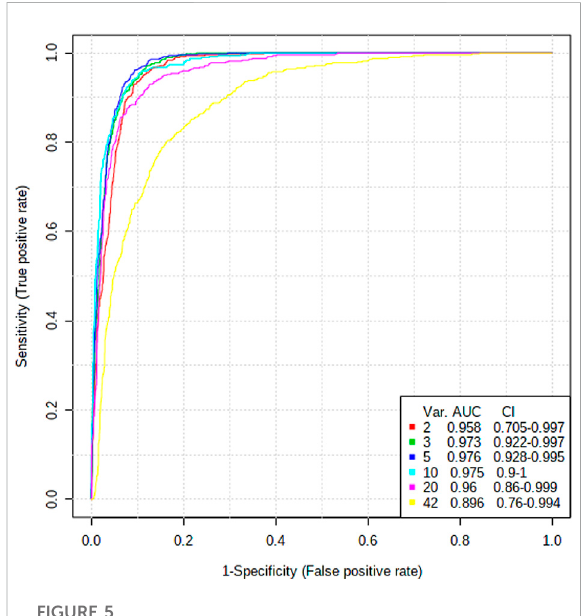
ROC curve analysis of 14 potential biomarkers between control and model